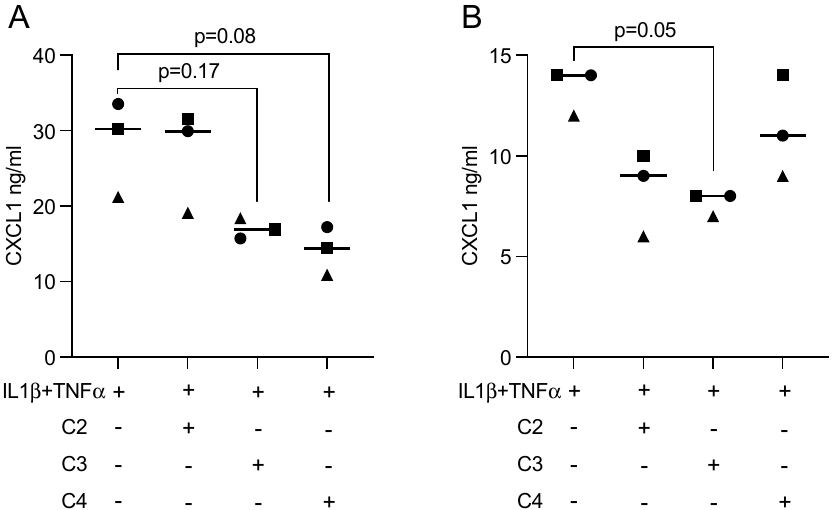
Figure 5. Immunoassay showed that propionate and butyrate suppress the expression of CXCL1 in ( A ) gingival fibroblasts and ( B ) HSC2 oral epithelial cells. Each format shape represents data from individual experiments with the median. Statistical analysis was based on the Friedman test and corrected p -values are indicated.